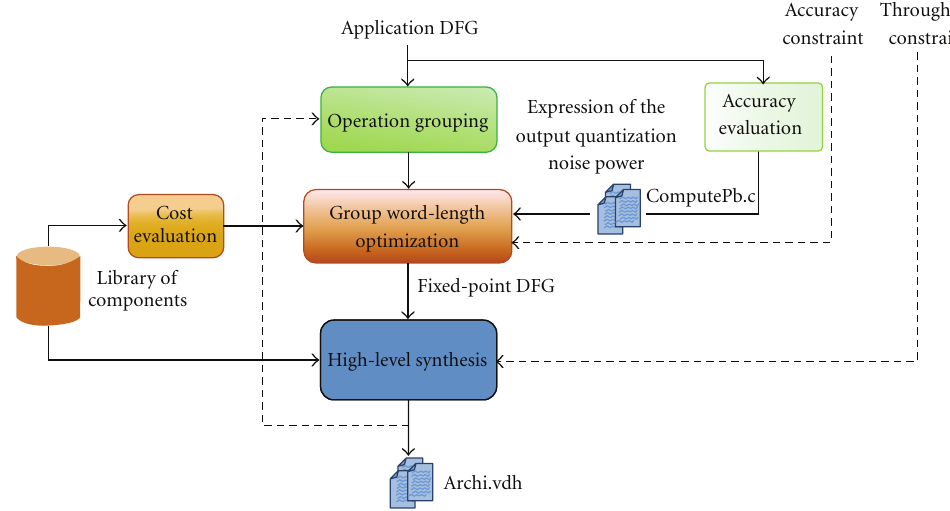
Figure 1: Combined HLS and WLO